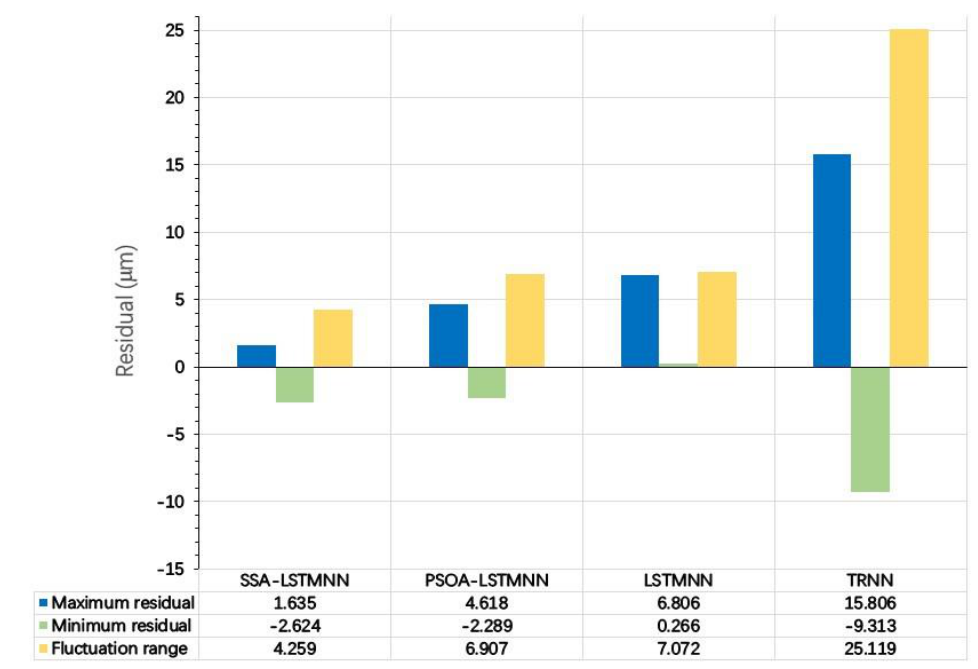
Figure 23. Residual details of each model at speed V 3 = 8000 mm/min.